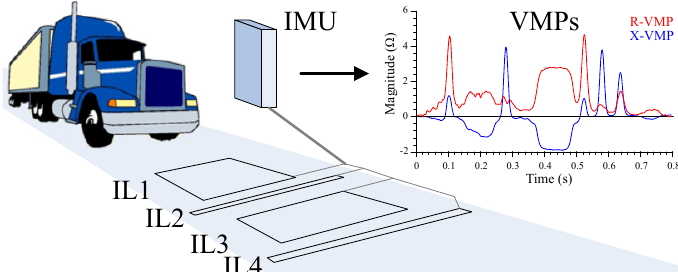
Figure 2. Inductive loop (IL) sensors arrangement on lane, impedance measurement unit (IMU), and vehicle magnetic profiles (VMPs) example from IL2 for a single frequency.